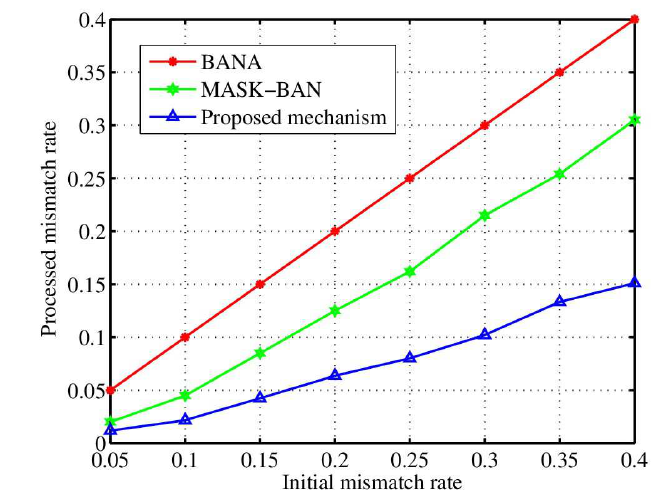
Figure 5. The influence of inconsistent initial bits on the inconsistent key rate.